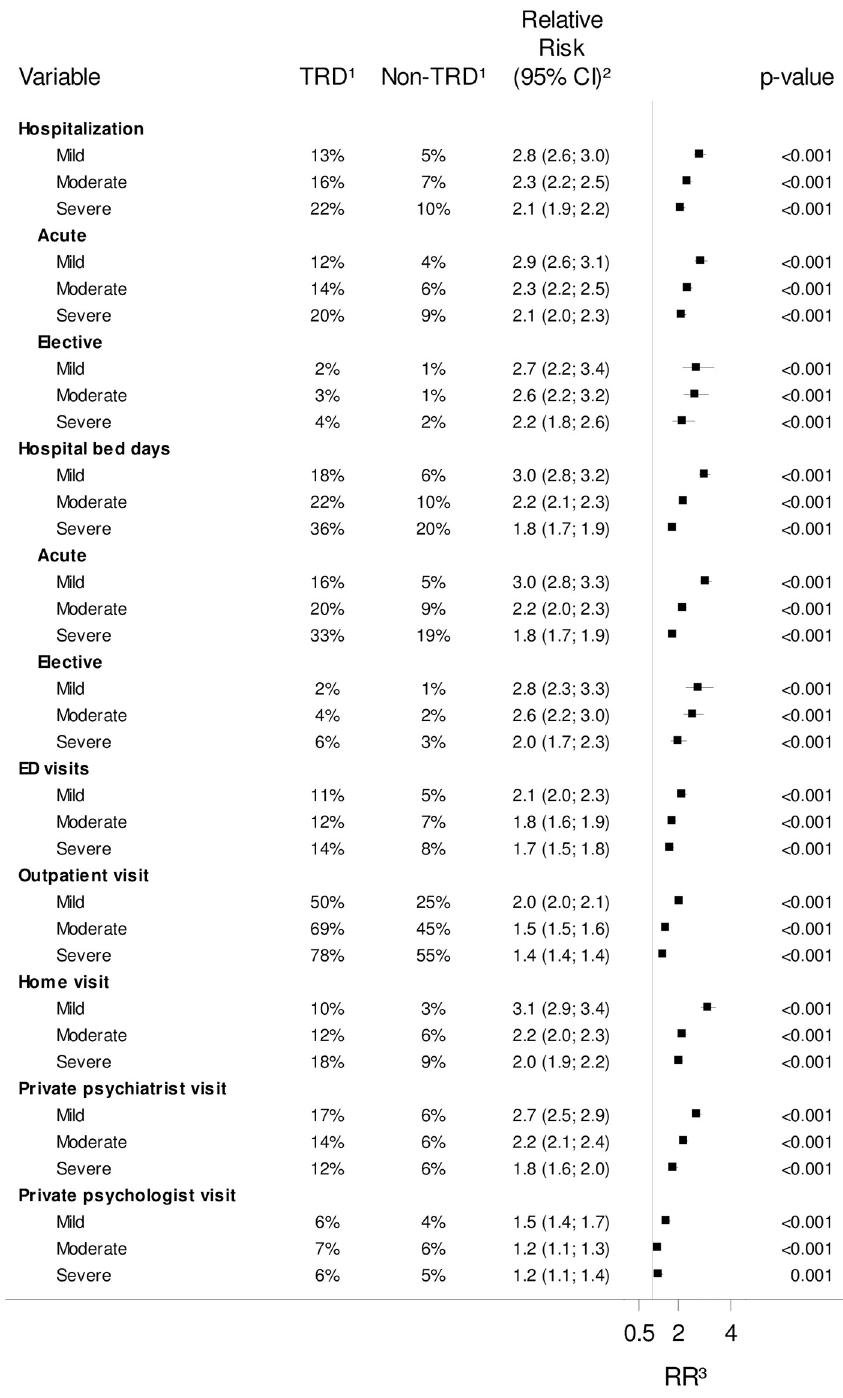
Fig 2. Psychiatric healthcare resource utilization by depression severity. 1 The fraction of users of the given psychiatric healthcare service for TRD patients and non-TRD patients of the match population in the year following the index date. 2 The relative risk (RR) estimate comparing TRD with non-TRD patients in each stratum is presented with 95% confidence interval (CI) and P-value. 3 Vertical line represents RR = 1.